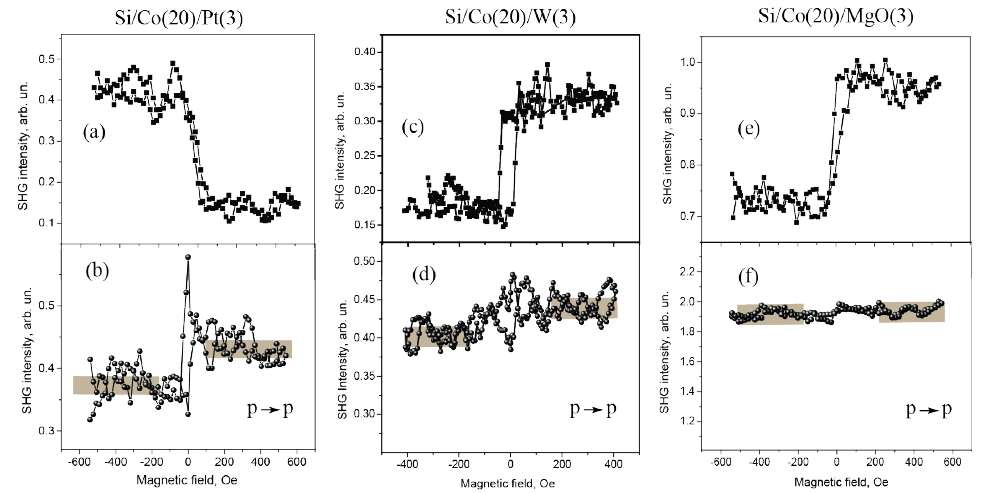
Figure 2. ( a , c , e ) Magnetic hysteresis loops of the SHG intensity measured in the geometry of allowed MOKE − SHG (mixed SHG polarization) for Si/Co(20)/Pt(3), Si/Co(20)/W(3), and Si/Co(20)/MgO(3) films, respectively; and ( b , d , f ) magnetic hysteresis loops of the ”forbidden” MOKE − SHG (as the p − polarized SHG intensity was measured).